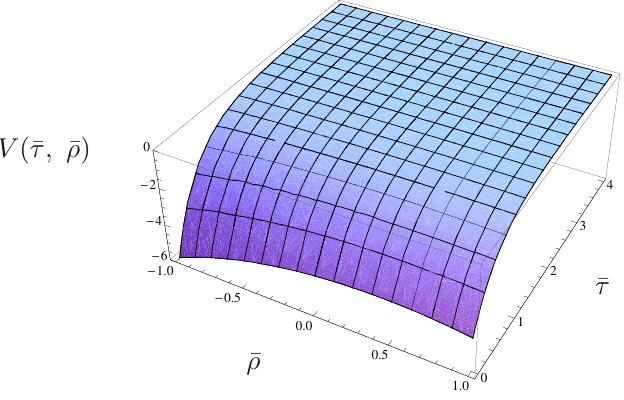
Figure 1 . We depict the moduli potential V (¯ τ, ¯ ρ ) in the type IIA theory for the case of R (Y) = 1, A Y = 1, A H = A p = A D p = 0, and A O p d p − 3 x √ g p − 3 = 1 , ( p = 4 , 6 , 8). We also fix κ = 1 [34]. The moduli potential has negative value. R